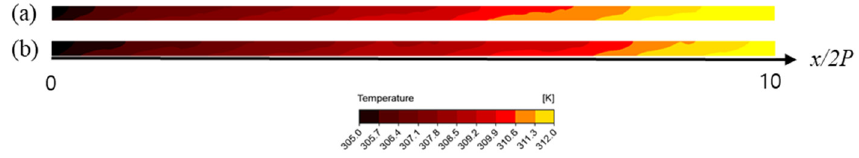
Figure 9. Temperature distributions on a right side wall: ( a ) smooth microchannel and ( b ) refer- ence design.